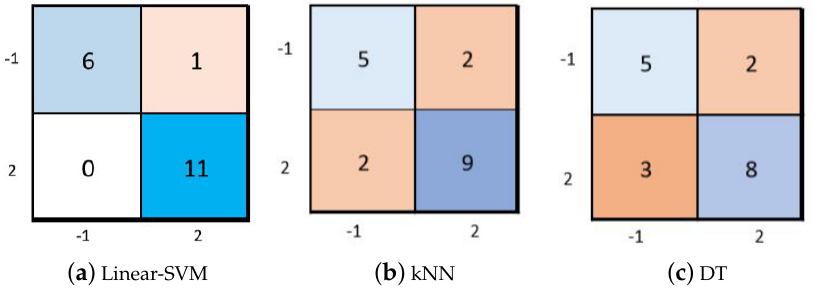
Figure 4. Confusion matrices of different Machine Learning (ML) models. Label − 1 and 2 indicate control and class 2 subjects,